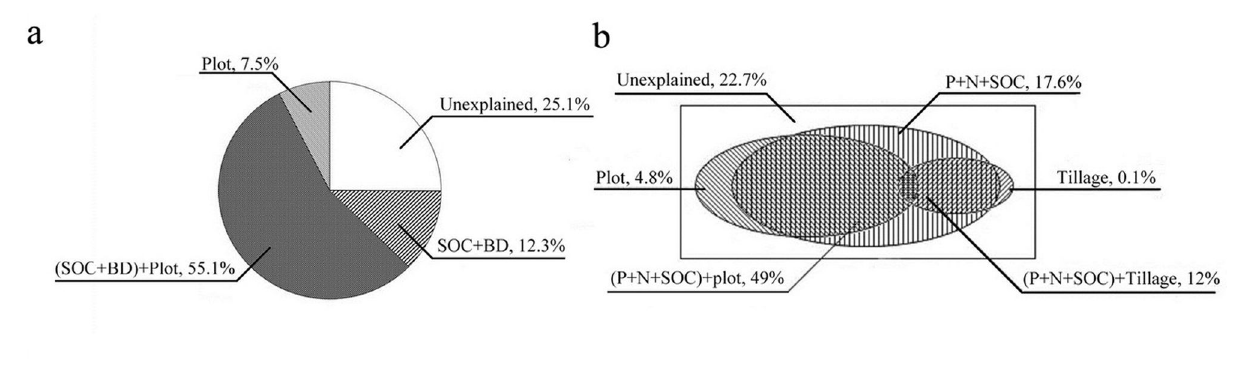
Figure 4. Variance partitioning with partial RDA of soil productivity based on significant soil variables, historical erosion (plot), and farming method data (set) in (a) different erosion intensities with no-tillage operation and (b) same erosion intensity but different farming method systems. Monte Carlo permutation test was performed on each set without the effect of the other by freely permuting samples (499